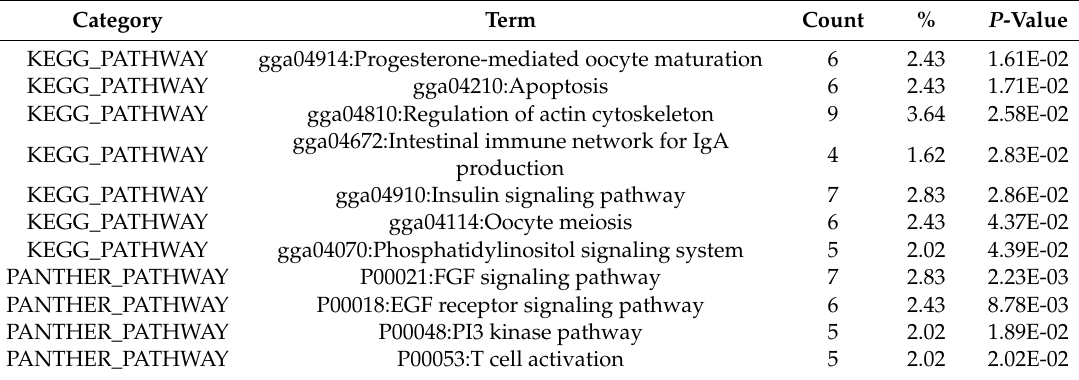
Table 8. DAVID analysis of ASE genes in response to MDV infection ( P < 0.05). 328